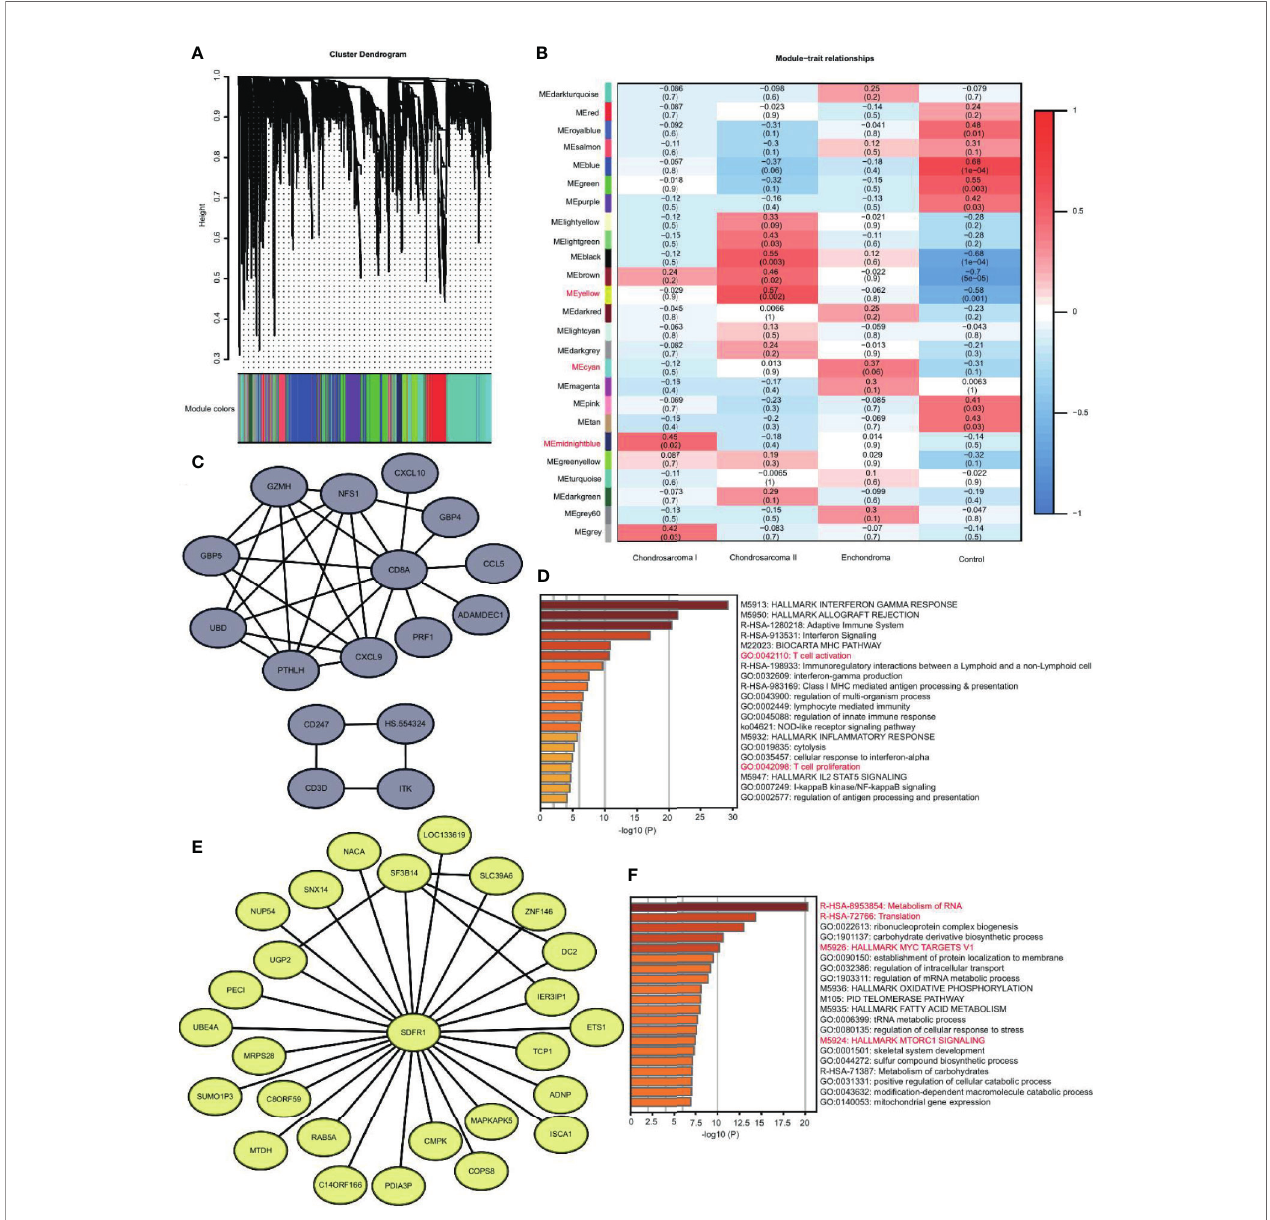
FIGURE 3 | The unique gene expression modules in EC, CS I, and CS II. (A) Gene dendrogram obtained by average linkage hierarchical clustering. The color row underneath the dendrogram shows the module assignment. (B) Correlation heatmap of the modules to disease types. Each row corresponds to a module and the columns are disease types. Red and blue represent high and low correlation, respectively. The values in the cells are presented as Pearson r (p value). (C) Visualization of network with the genes of top-weighted connectivity in the midnight blue module. (D) Metascape enrichment analysis of genes in the midnight blue module. The color shows the p value. (E) Visualization of network with the genes of top-weighted connectivity in the yellow module. (F) Metascape enrichment analysis of genes in the yellow module. The color shows the p